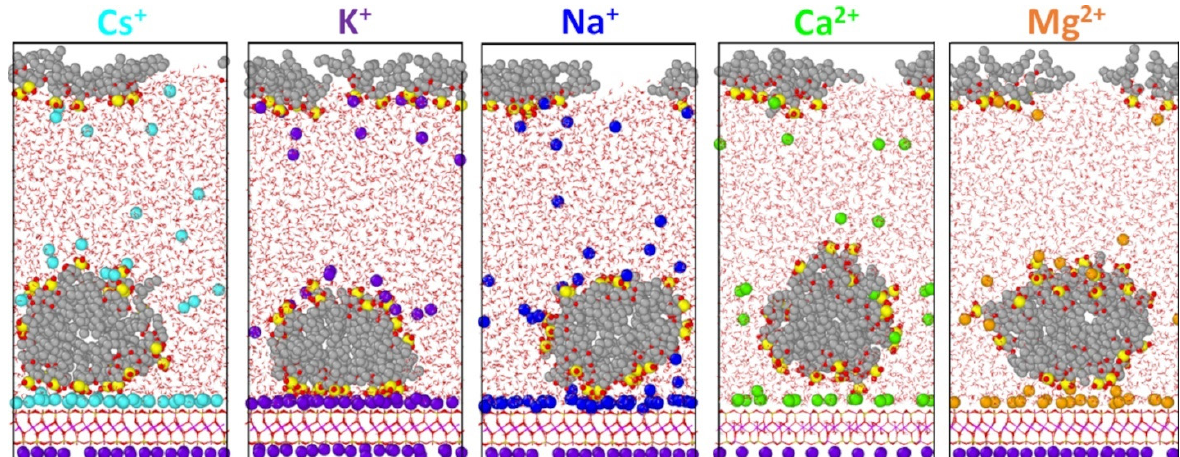
Figure 2. Snapshots from MD simulations of 32 AOT systems at 300 K showing adsorbed cylindrical AOT micelles in the yz plane for different counterions. Atom rendering and coloring is the same as Figure 1 with aqueous cations shown as large spheres (purple = K + , light blue = Cs + , blue = Na + , green = Ca 2+ , dark orange = Mg 2+ ).